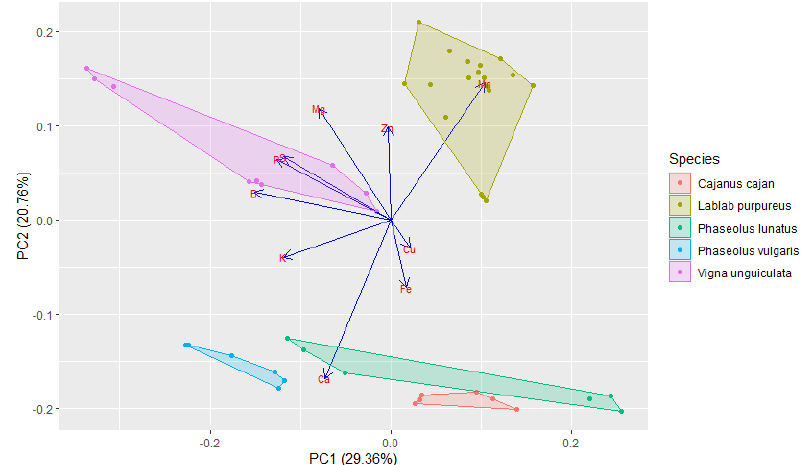
Figure 4. Representation of the two first components (PC1 and PC2) resulting from the principal component analysis, which explain 50.12% of the diversity of mineral contents in beans of the five most cultivated and traded legume species of Cabo Verde in a space defined by the vectors and own values. The arrow lengths show differences in variance explained relative to each other.